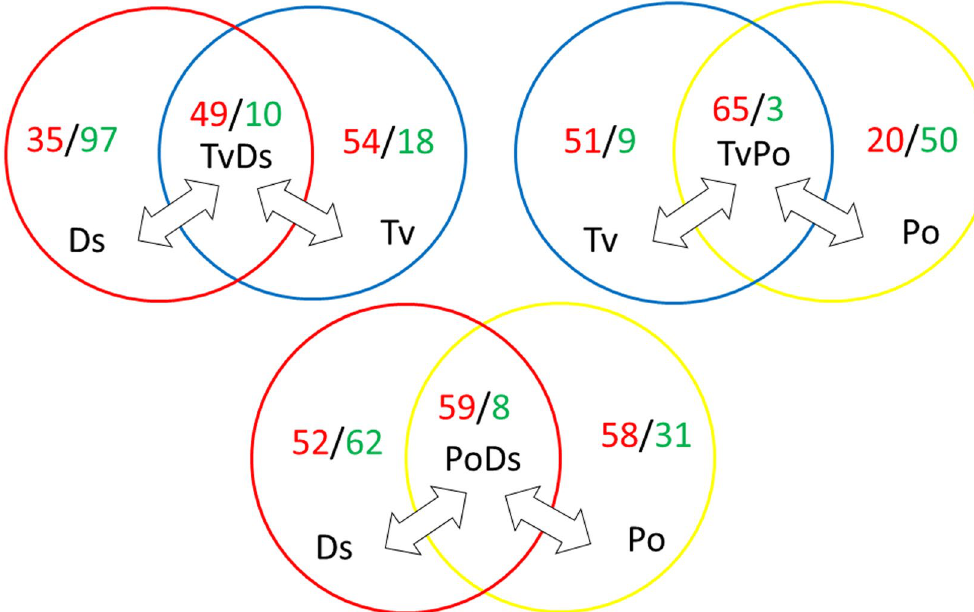
Figure 2. Significant changes of compounds in each interaction zone compare to the two isolates. Ratios as: up- regulated numbers/down-regulated numbers, p-value ≤ 0.05 was taken as significant.